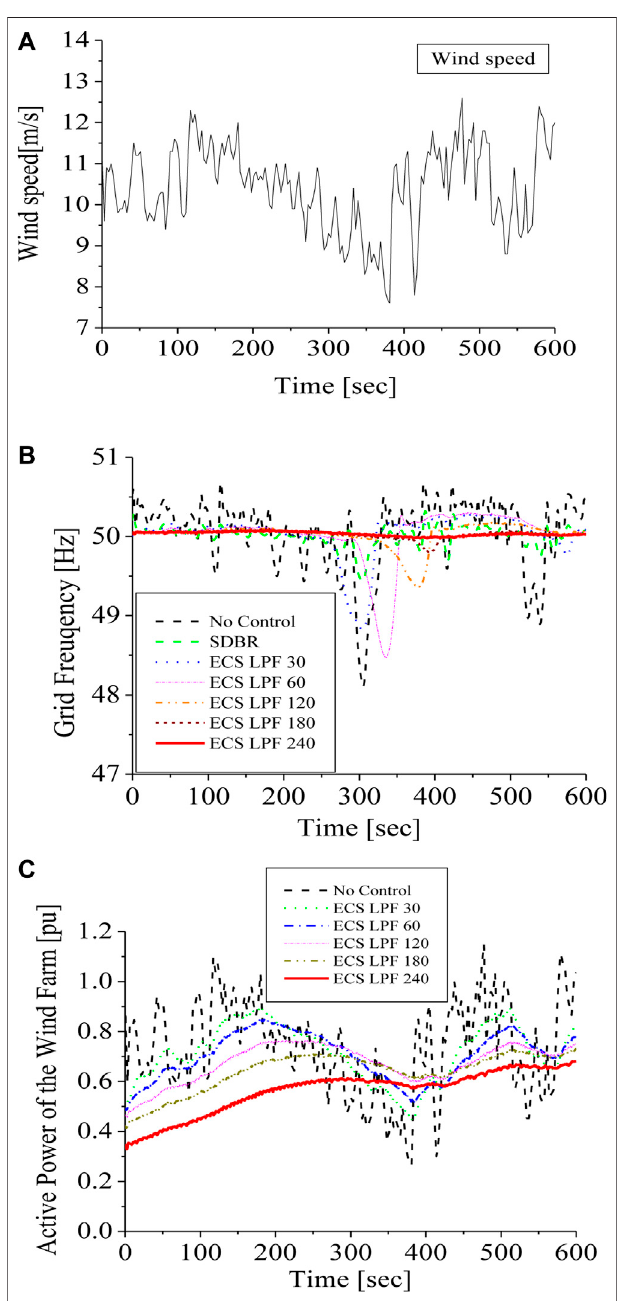
FIGURE5| Dynamicsofthesystemwithconstantload. (A) Windspeed. (B) Grid frequency. (C) Active power.